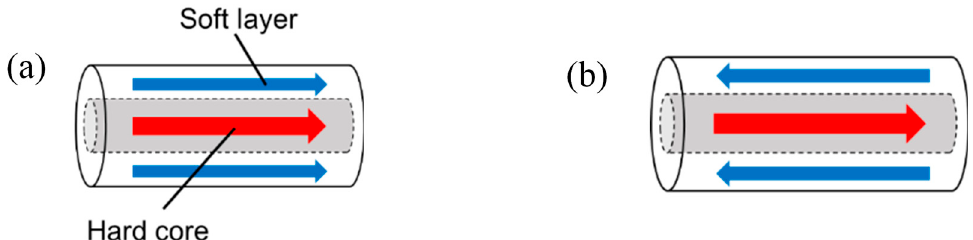
Figure 1. Two states of magnetization of the FeCoV wire: ( a ) parallel state and ( b ) antiparallel state.